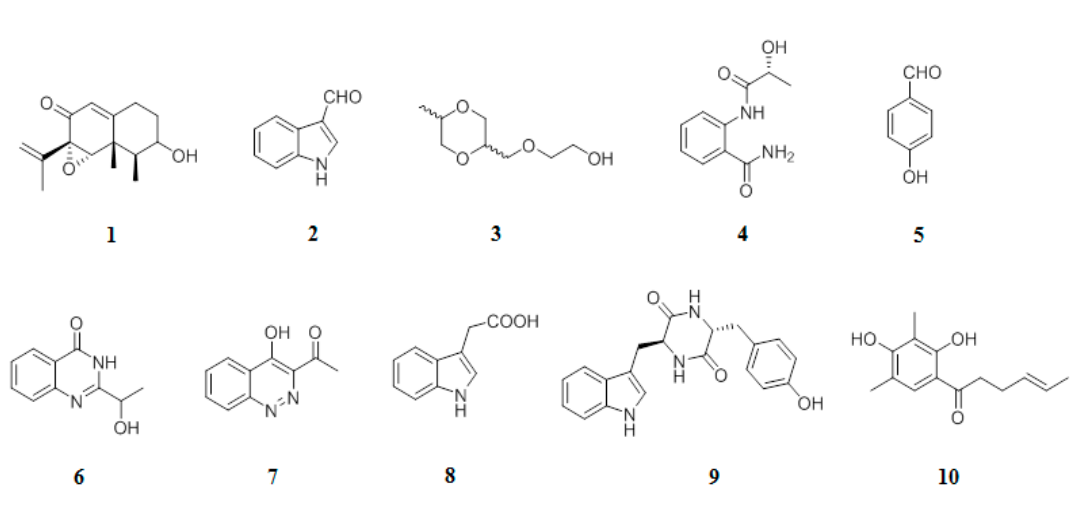
Figure 2. Chemical structures of compounds 1–10 .